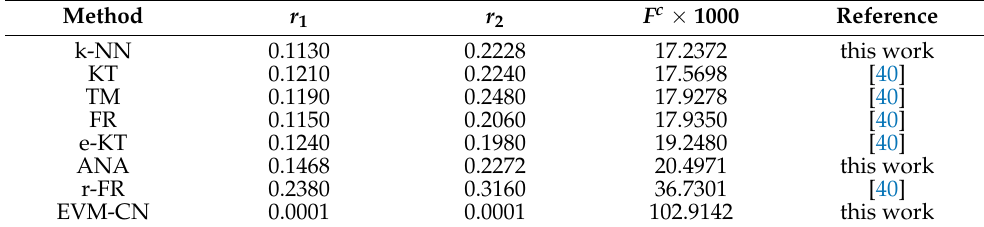
Figure 19. Distribution of P cen (r 1 , r 2 ) points for each step of searching for the k-NN method for co- polymerization of 2-(N-phthalimido) ethyl acrylate with 1-vinyl-2-pyrolidone (NPEA-NVP) [39].